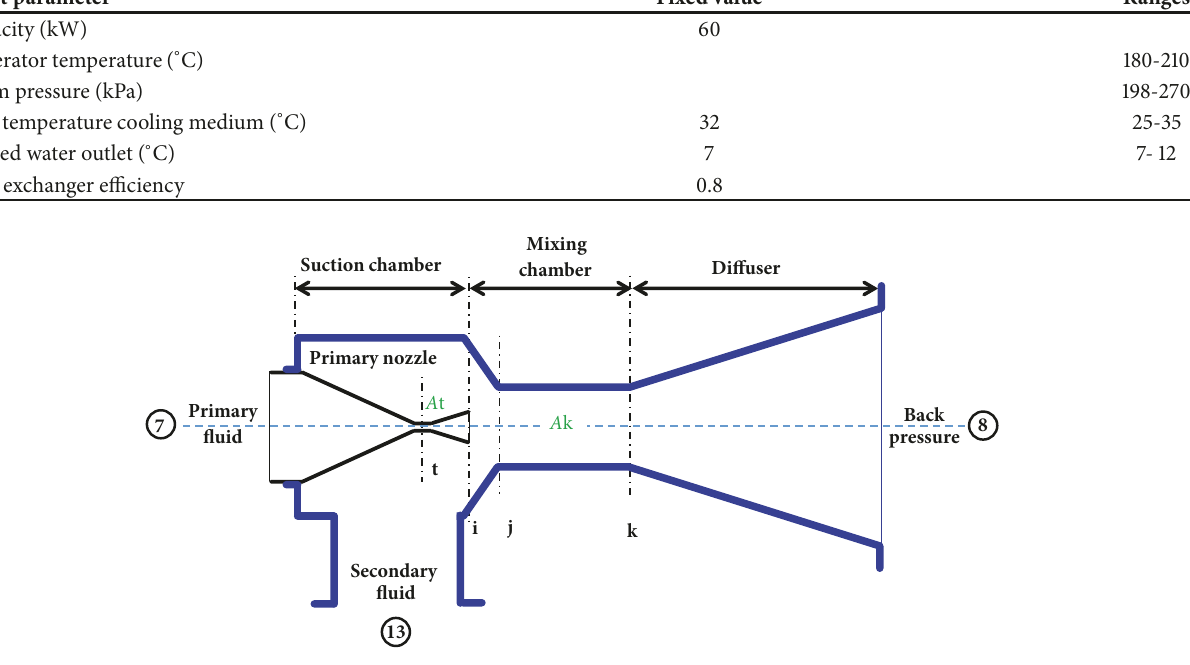
Figure 3: Schematic diagram of ejector.